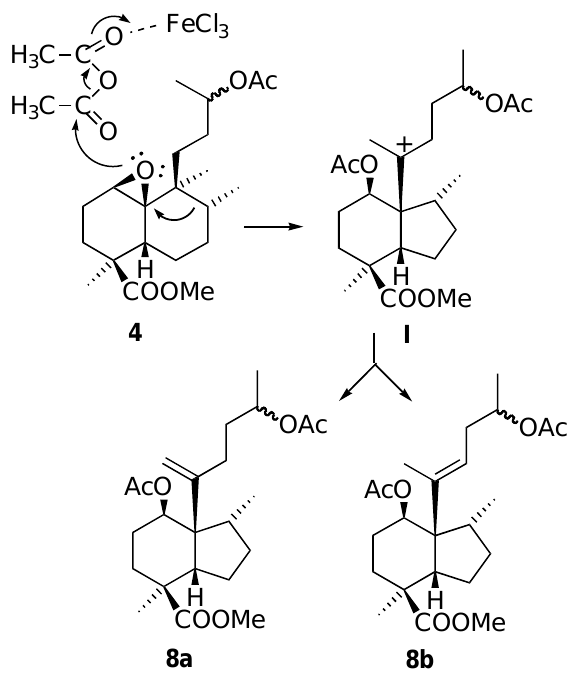
Figure 5. Proposed mechanism for the formation of 8